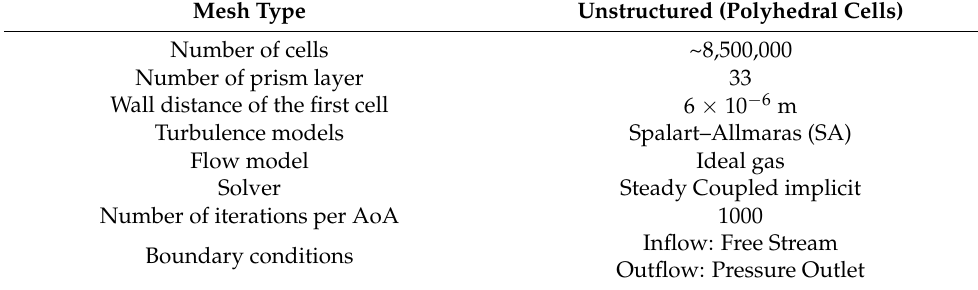
Table 3. Flight conditions.